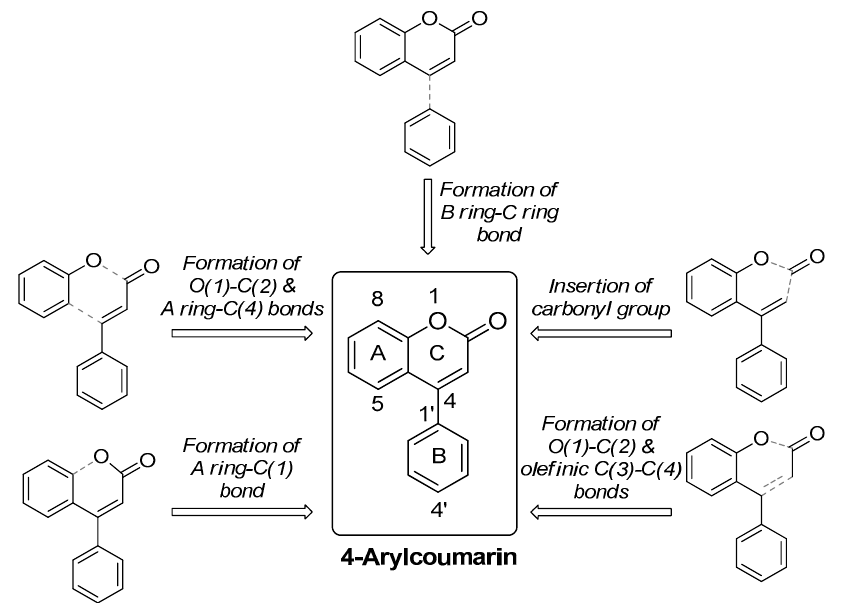
Figure 1. Representative synthetic routes toward 4-arylcoumarin.